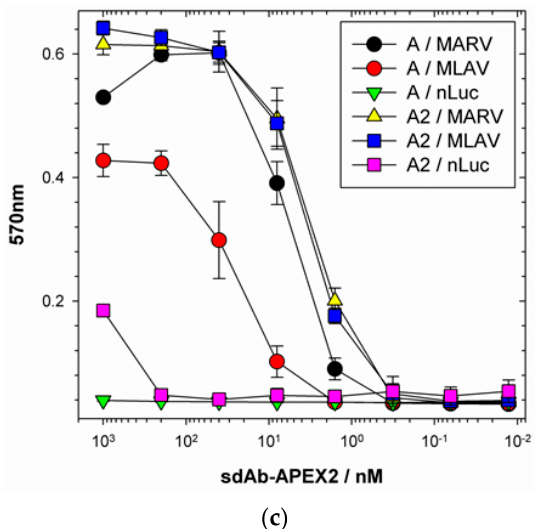
Figure 6. ( a ) DAB staining of HEK293T cells following the transient expression of either MARV, MLAV or EBOV NP genes followed by probing with 10 nM either monomeric (sdAb A and sdAb E) or dimeric (sdAb A2 and sdAb E2) APEX2 fusion proteins. Negative controls were β -galactosidase plasmid transfection and untransfected cells and magnification was at 10 × . ( b ) DAB developed Western blots of HEK293T cell lysates after the transient expression of the MARV, MLAV, EBOV NP genes, or a control β -galactosidase gene and probing with 10 nM of either monomeric (sdAb A and sdAb E2) or dimeric (sdAb A2 and sdAb E2) APEX2 fusion proteins. Coomassie-stained 12% gel of the lysates to show equivalent loading. Molecular weights of markers are indicated to the left in kDa. ( c ) Amplex ® UltraRed ELISA titration of monomeric versus dimeric anti-MARV sdAb–APEX2 fusions over immobilized nluc–NP C-terminal domain fusions of MARV or MLAV. Curves represent an n of 2 with error bars +/ − SD.